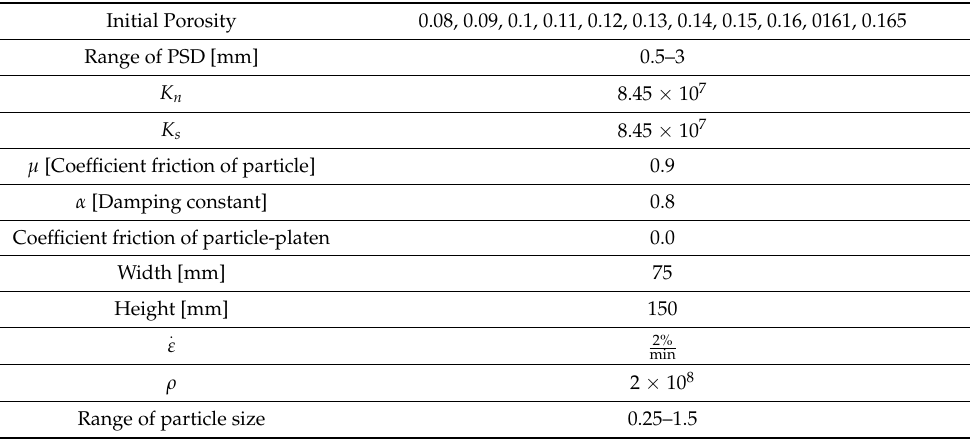
Table 2. The micro-mechanical properties of the irregular packing sample.